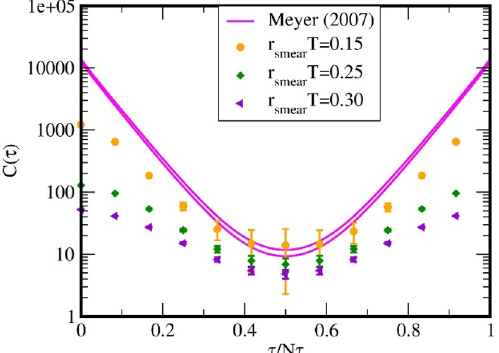
Figure 1 . Flow-time dependence of the T 12 correlation function. Here, the data of (cid:12) = 6 : 72 ; N 3 N (cid:28) = 48 3 (cid:2) 12 ( T = 1 : 65 T c ) are plotted. Magenta curves denotes the best-(cid:12)t function with 1- (cid:27) error of the (cid:12)tting parameters which is reconstructed by the estimated spectral function by using the Breit-Wigner ansatz given in ref. [14] . It indicates a non-smeared correlation function. p r smear T = 8 t=aN (cid:28) , where t denotes the (cid:13)ow-time. This plot is (cid:12)rstly shown in ref.